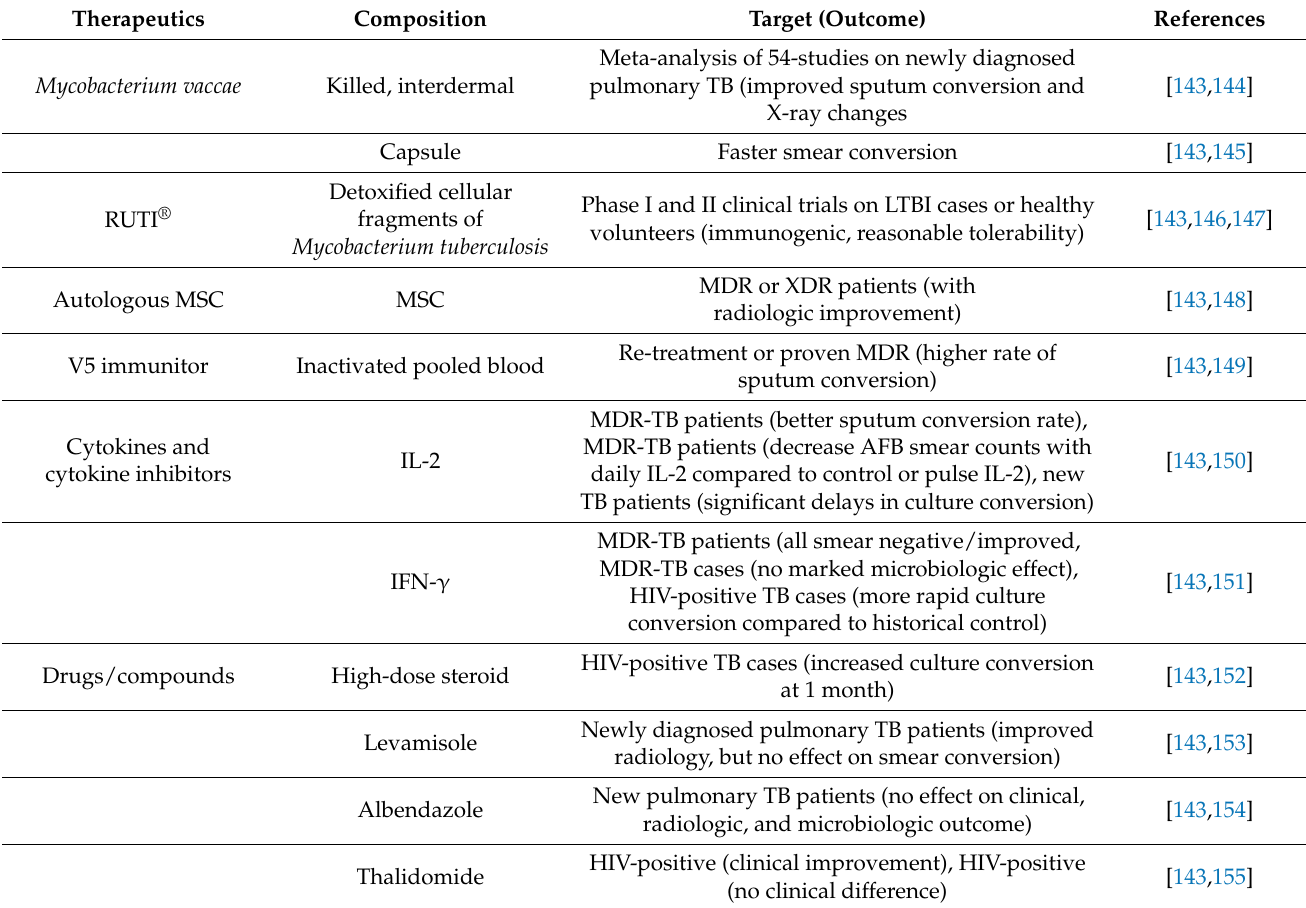
Table 2. Immunomodulating immunotherapies for treatment of TB in